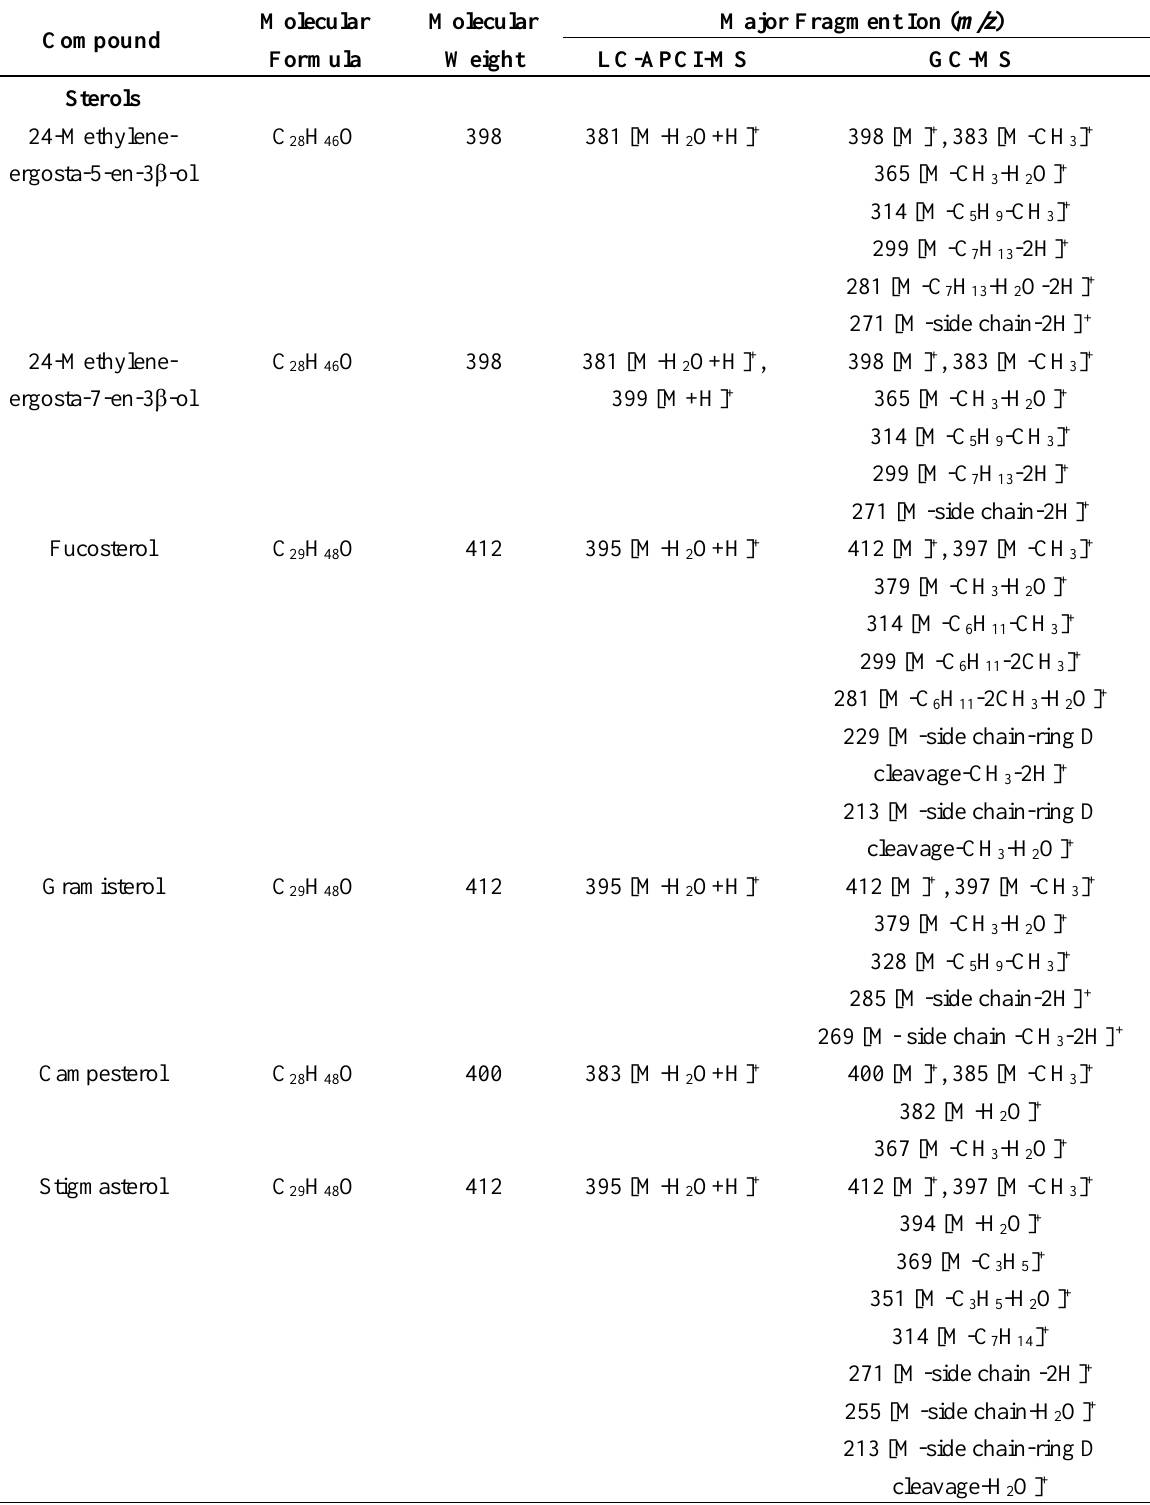
Table 2. Mass spectral data of the identified black rice bran sterols and